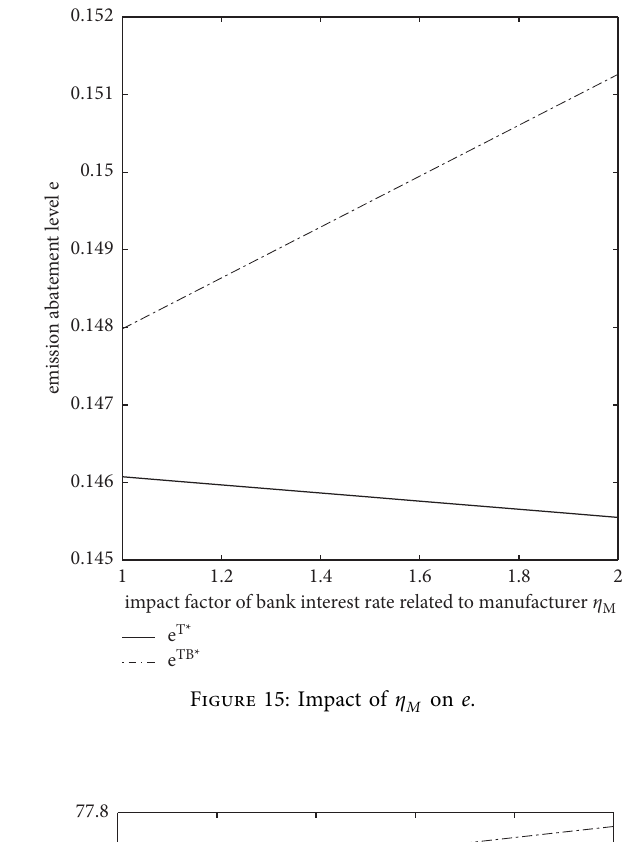
Figure 13: Impact of ϕ on π